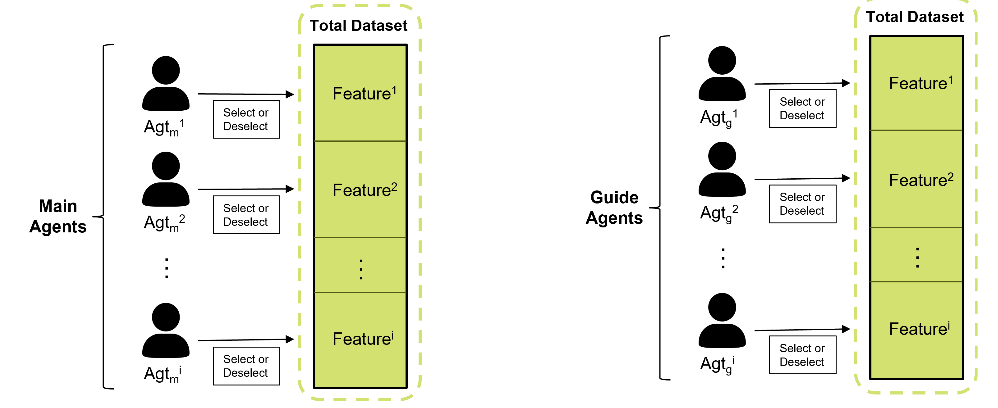
Figure 3. Initializing Main Agents and Guide Agents.